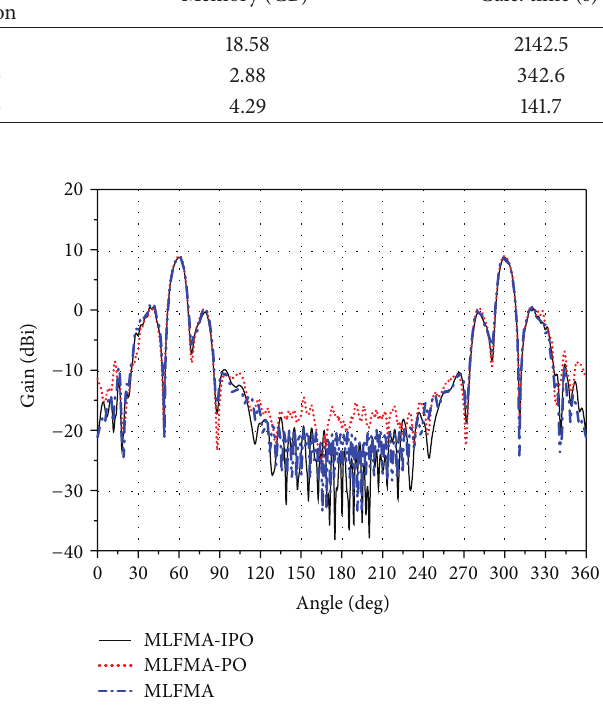
Figure 8: The far-field gain pattern in XOZ plane of the monopole installed on the folding